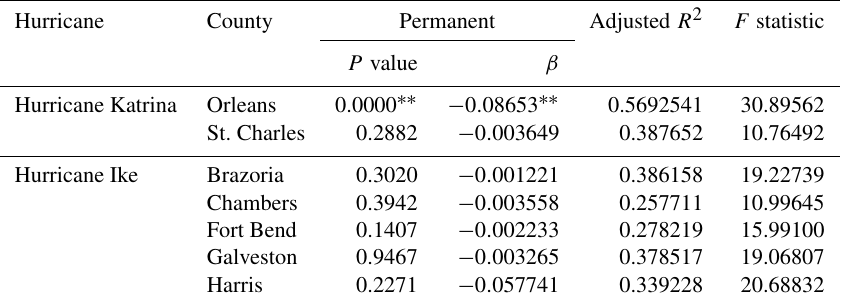
Table 4. Results of permanent impact for employment. Statistical significance at the 5% level is indicated by a double asterisk ( ∗∗ ) Hurricane